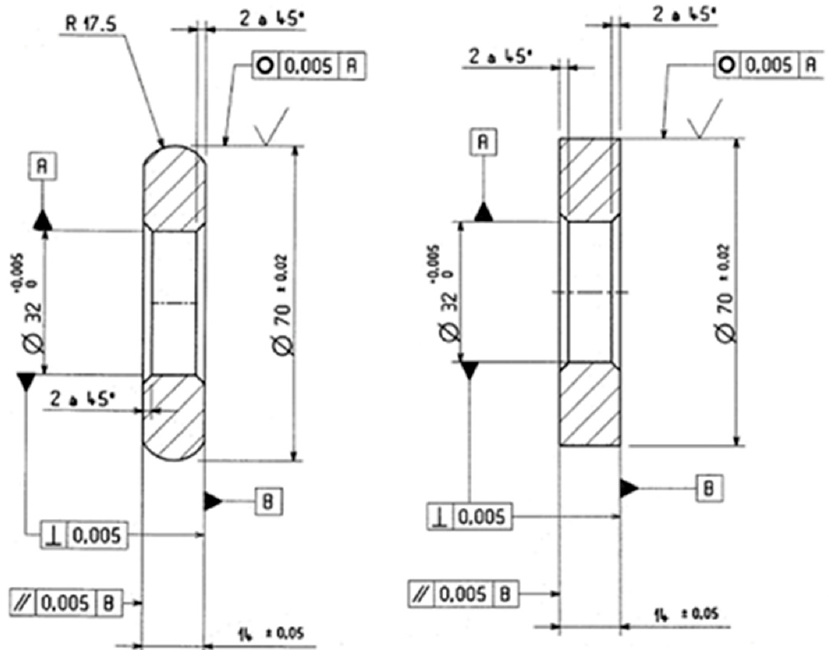
Figure 5. Drawing of ring specimens.